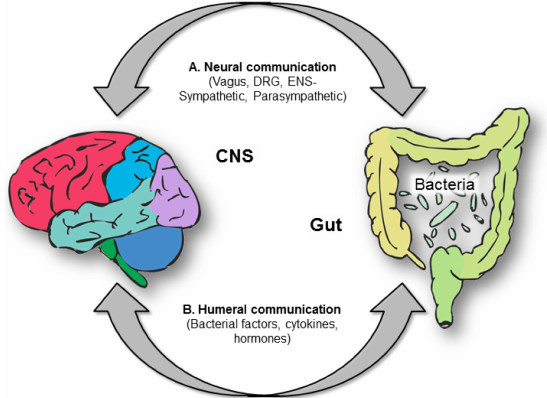
Figure 1. The brain-gut axis and the bi-directional system of communication. The brain-gut axis is a bi-directional system of communication between the brain and the gastrointestinal tract. This links emotional and cognitive centres of the brain with peripheral control and function of the gut and its resident microbiota. Serotonin is a key element of this axis, acting as a neurotransmitter in the CNS and in the enteric nervous system that is present in the wall of the gut. A. Neural communication between the gut and brain is via the vagus (stomach and rectum) and dorsal root ganglia (DRG-small and large intestine), via projections from the enteric nervous system to sympathetic ganglia and parasympathetic innervation of the gut. B. Humeral communication is via release of bacterial factors, production of cytokines and circulating hormones. An important advance for future studies will be testable models of a potential mechanism of action (e.g., cutting the vagus can block some effects of changing the gut microbiota in rodent